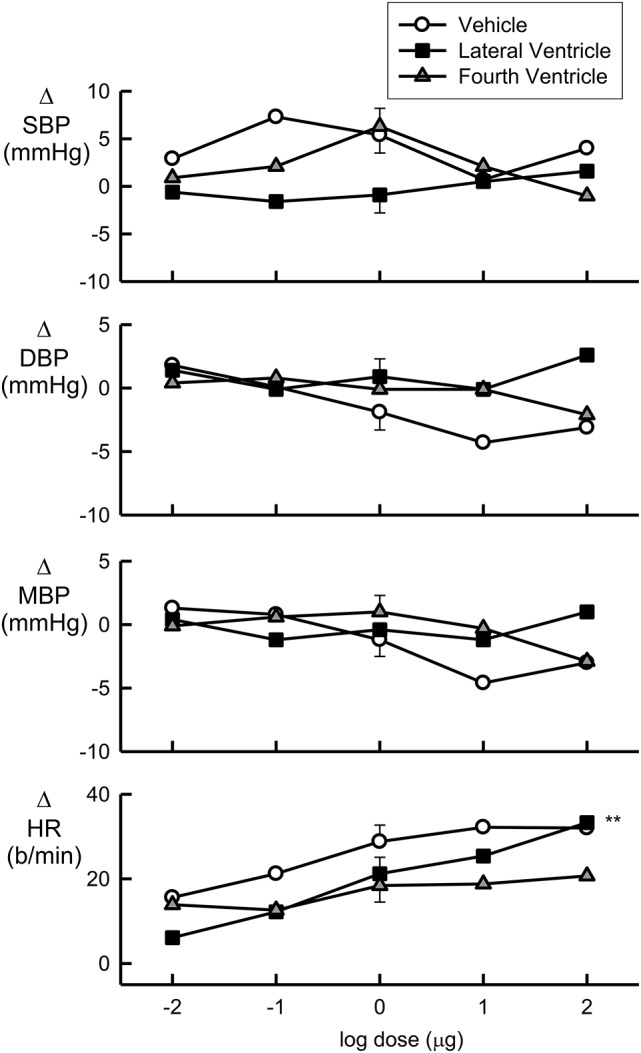
Log dose response curves for Urotensin II and vehicle showing the changes in the baroreflex cardiovascular parameters of systolic blood pressure (SBP, mmHg), diastolic blood pressure (DBP, mmHg), mean blood pressure (MBP, mmHg), and heart rate (HR, beats per min), expressed relative to the initial control parameters. Error bars are SEM indicating animal variance between doses within groups.